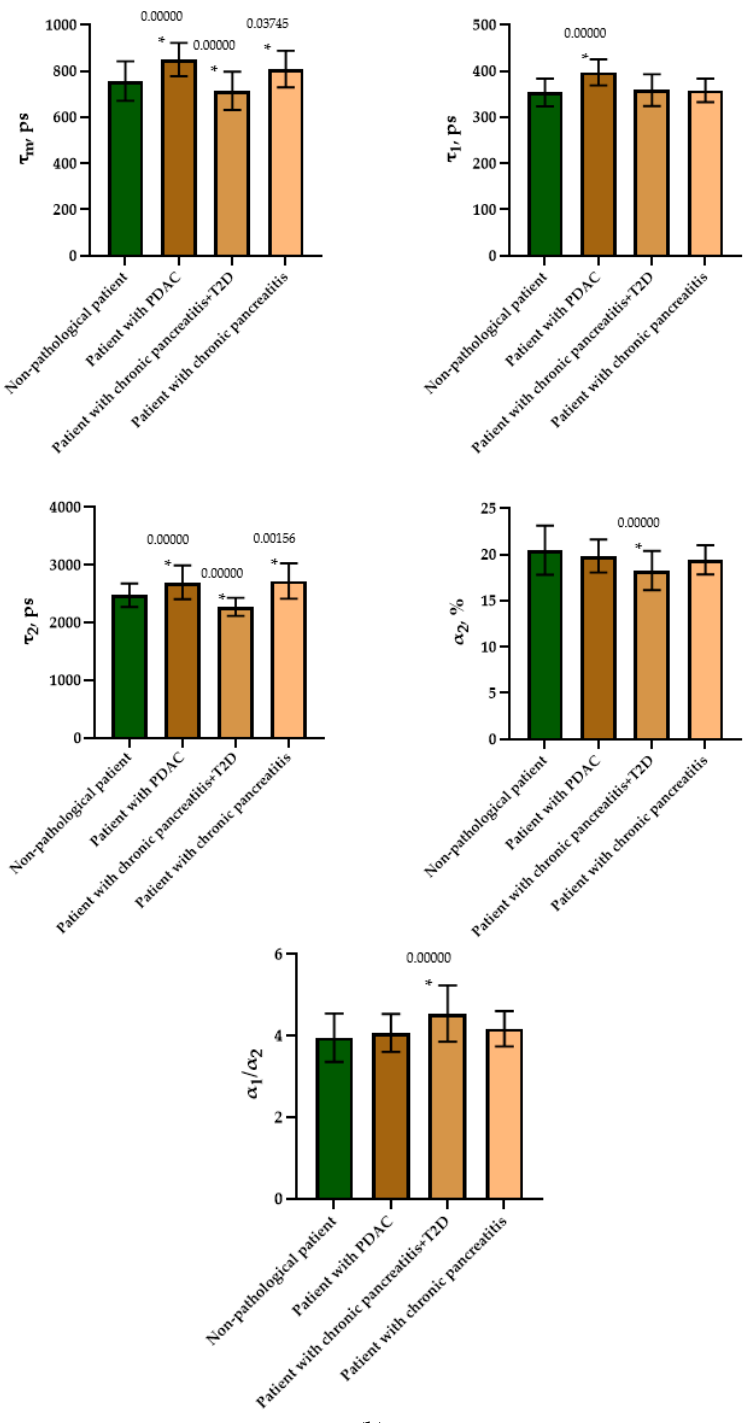
Figure 7. FLIM of NAD(P)H in human islets of nonpathological patient and islets with pathologies (PDAC, chronic pancreatitis + T2D and chronic pancreatitis). ( a ) Pseudo-color-coded images of τ m, τ 1, τ 2, α 2 and α 1/ α 2 of the NAD(P)H in human islets of nonpathological patient and islets with pathologies (scale bars: 600–1100 ps ( τ m), 200–500 ps ( τ 1), 1500–3000 ps ( τ 2), 10–25% ( α 2) and 1–6 ( α 1/ α 2)). The scale length in all pictures is 100 µm. ( b ) Mean values of τ m, τ 1, τ 2, α 2 and α 1/ α 2 of the NAD(P)H in human islets of nonpathological patient and islets with pathologies (mean ± SD). *— p ≤ 0.05.